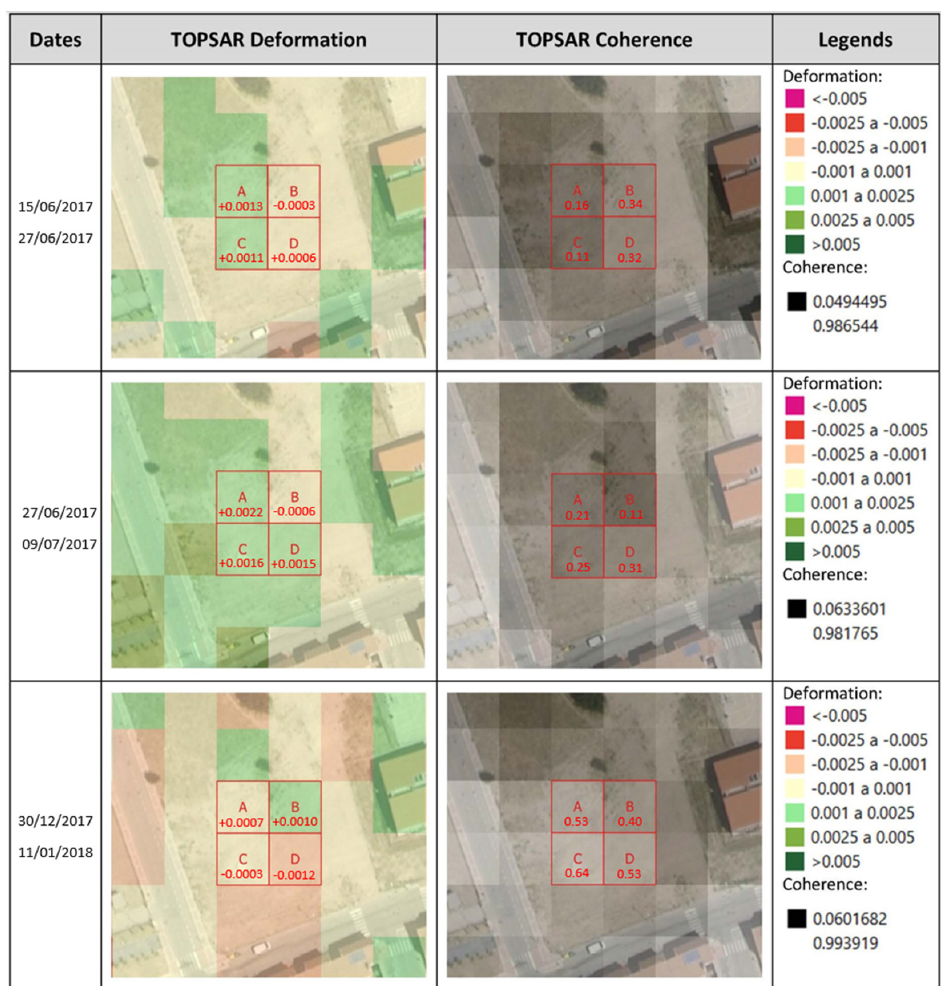
Figure 10. Examples of deformation measurements by Differential Interferometry over IW TopSAR images. Deformation values in meters. With A, B, C and D are indicated the equivalent TopSAR cells.